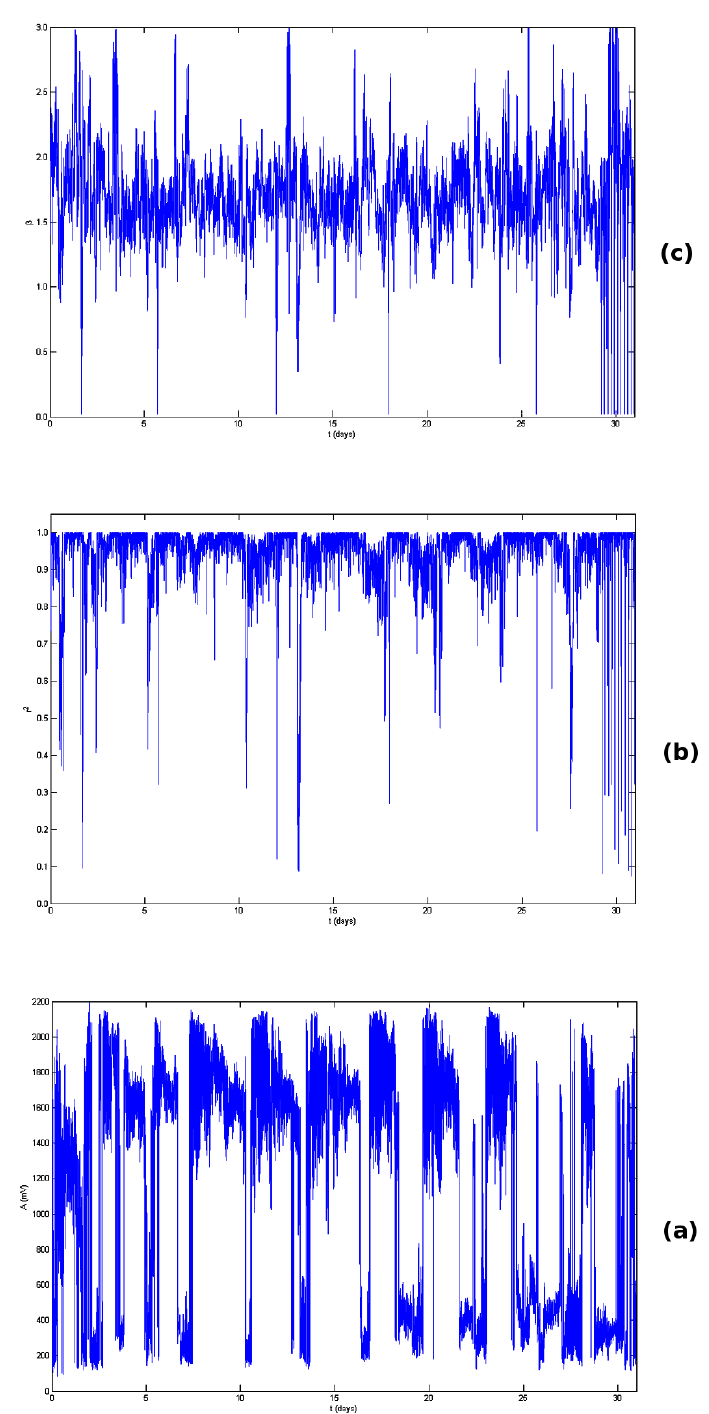
Figure 5. Results from fractal analysis: From bottom to top: ( a ) The EM time series; ( b ) The Spearman’s correlation coe ffi cient of the goodness of the linear fit of equation (18) in every 1024-sample window; ( c ) The time evolution of power-law β exponent. Horizontal axis is in days from the beginning of measurements (2018 / 10 / 26). The measurement sampling rate is 1 s − 1